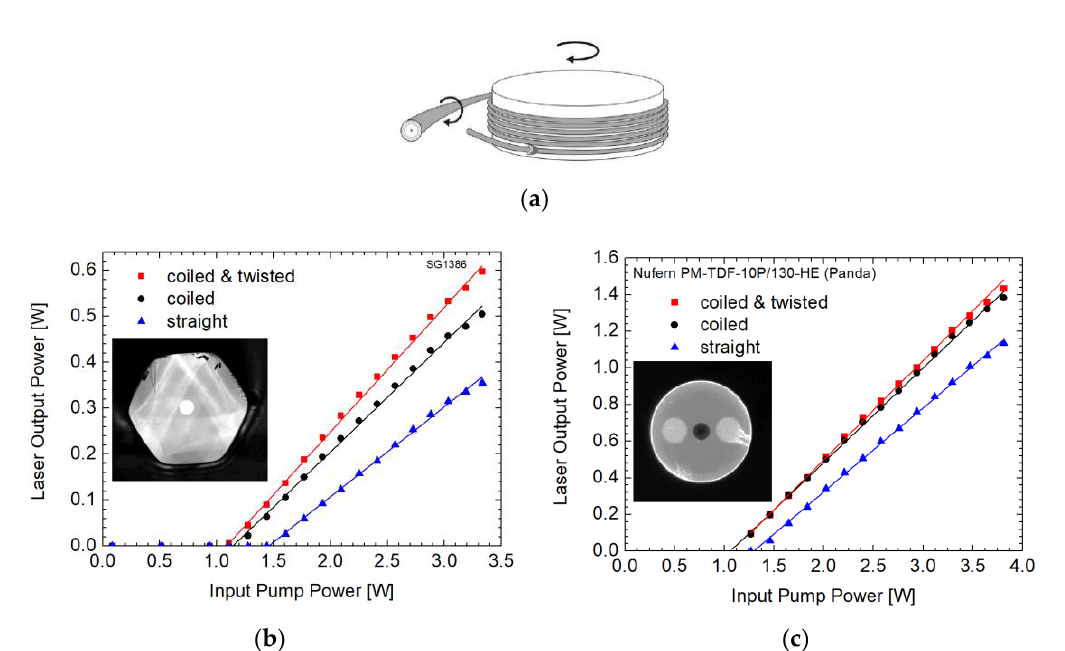
Figure 3. ( a ) Scheme of simultaneous coiling and twisting of the fiber; Laser characteristics under the conditions of straight, coiled, and coiled and twisted: ( b ) fiber with hexagonal shape of the inner cladding; ( c ) Panda fiber.